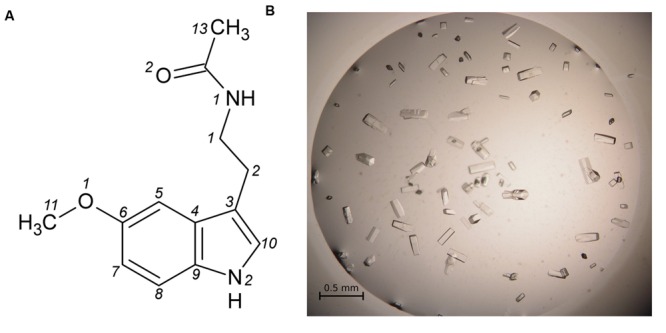
(A) Melatonin with atom numbering according to Quarles et al. (1974). (B) Single crystals of the Hyp-1/MEL complex grown in 1 M citrate and 20% glycerol.